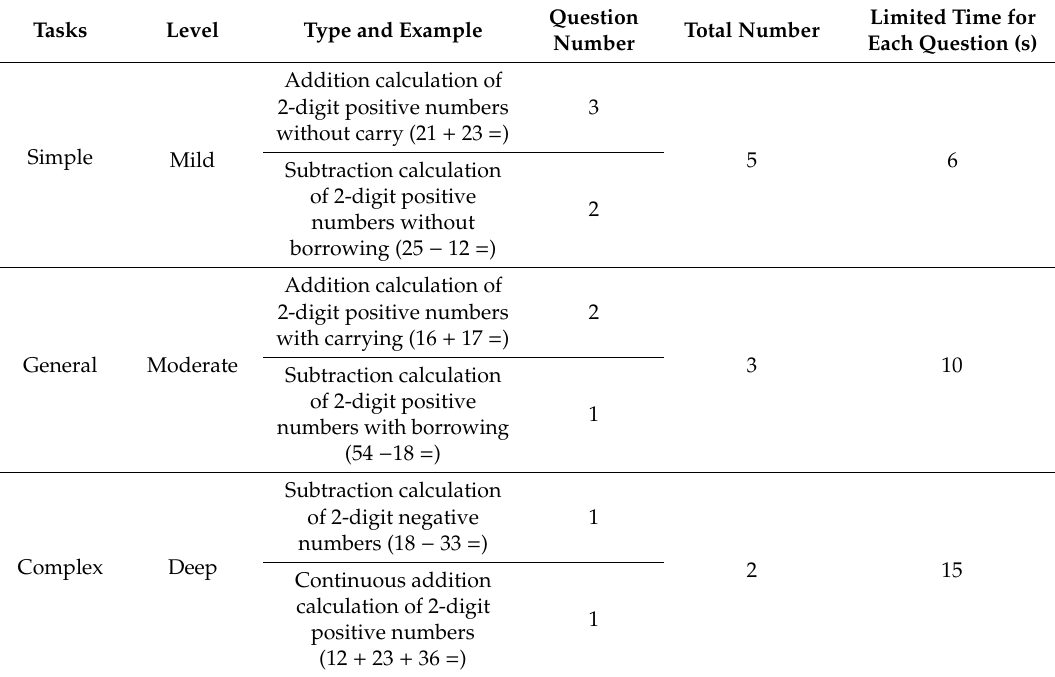
Table 2. Description of cognitive workload task under di ff erent levels.